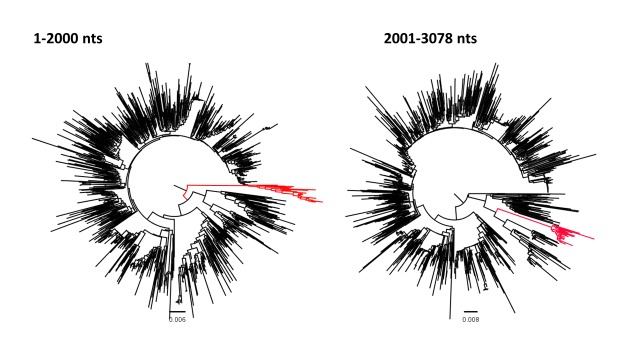
Phylogenetic analysis of genotype D including the RS-D5 in two non-overlapping subgenomic areas (1–2000 nts) and (2001–3078 nts). RS-D5 sequences are shown in red.